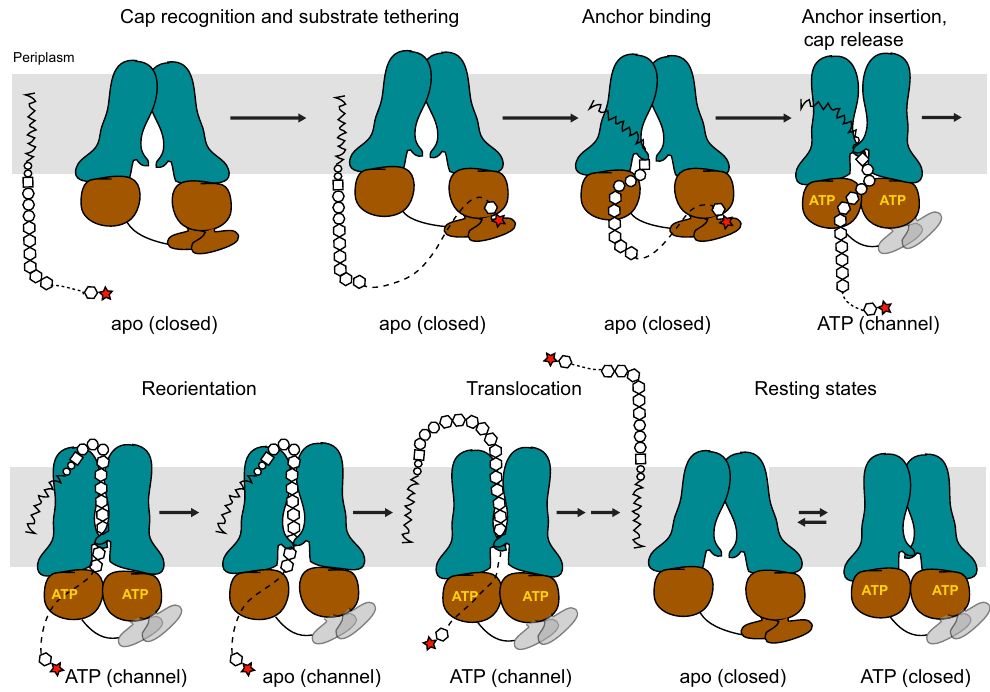
Fig. 7 | Model of O antigen translocation. CBD – O antigen interactions increase the local substrate concentration to initiate translocation. Cap interactions are likely disrupted in the transporter ’ s ATP-bound conformation due to CBD